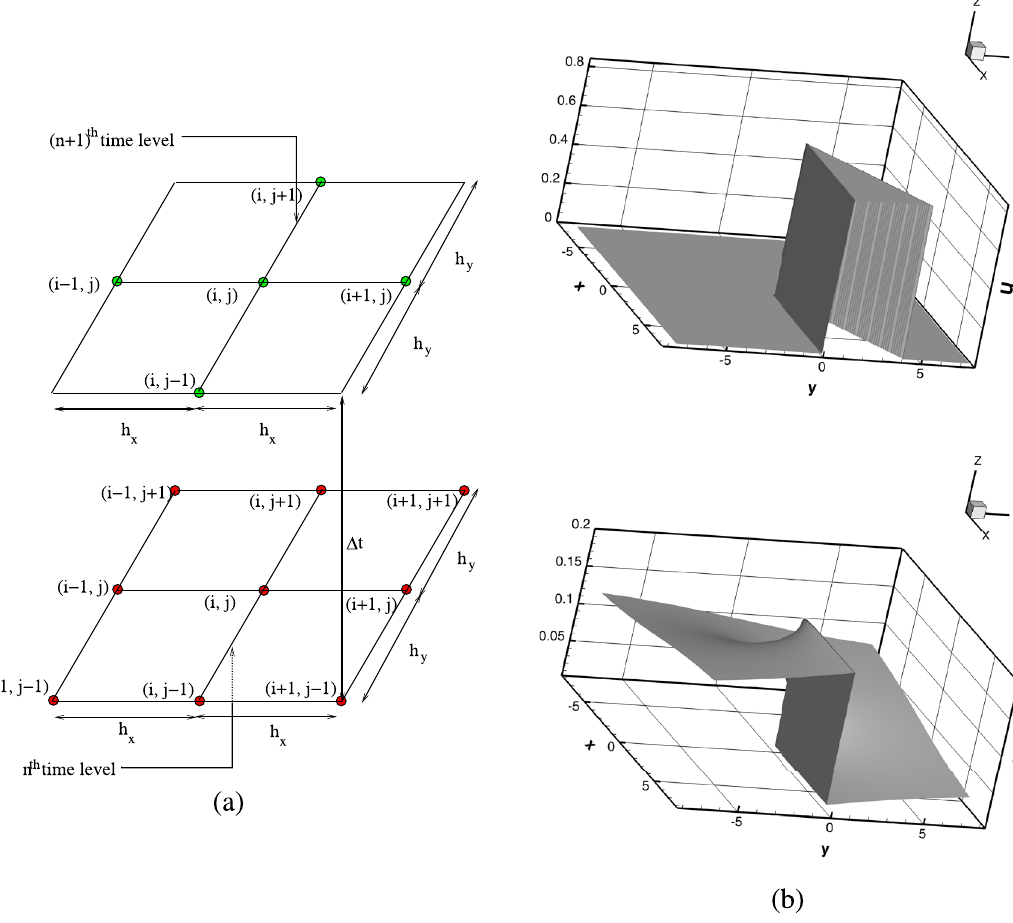
Figure 1. ( a ) Unsteady High Order Compact stencil for the R–D equation and ( b ) surface plots of the initial profiles of u and v .